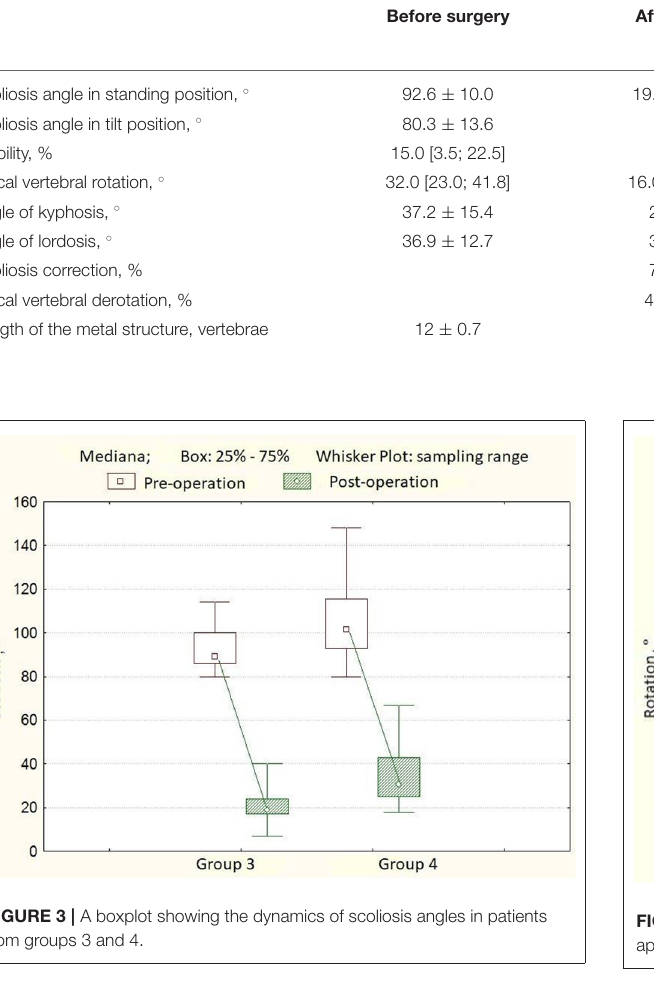
to 22, with an average of 18 screws. Twelve months after surgery, the magnitude of the scoliotic curve was 11.5 ◦ (7.0 ◦ -20.0 ◦ ), the angle of kyphosis was 23.0 ◦ ± 7.0 ◦ , and the angle of lordosis was 27.3 ◦ ± 5.4 ◦ .After 3 years of observation, the angle of